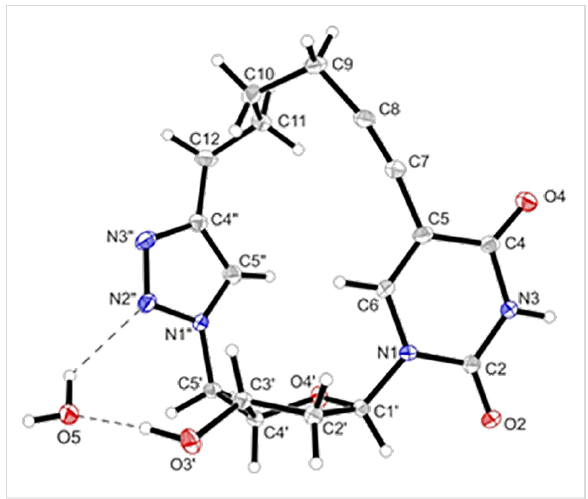
Figure 2: A perspective view of 8 showing the atomic numbering scheme. Displacement ellipsoids are drawn at the 50% probability level and H-atoms are shown as small spheres of arbitrary size. Hydro- gen bonds are shown as dashed lines.